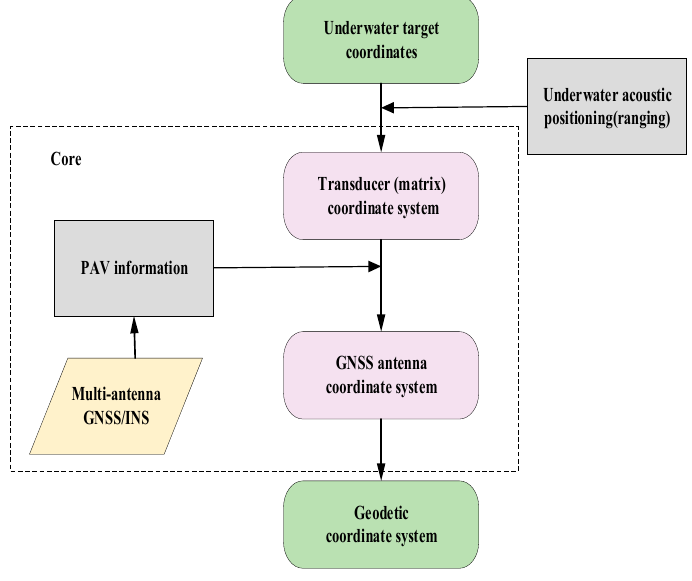
Figure 2. The coordinate transformation process.